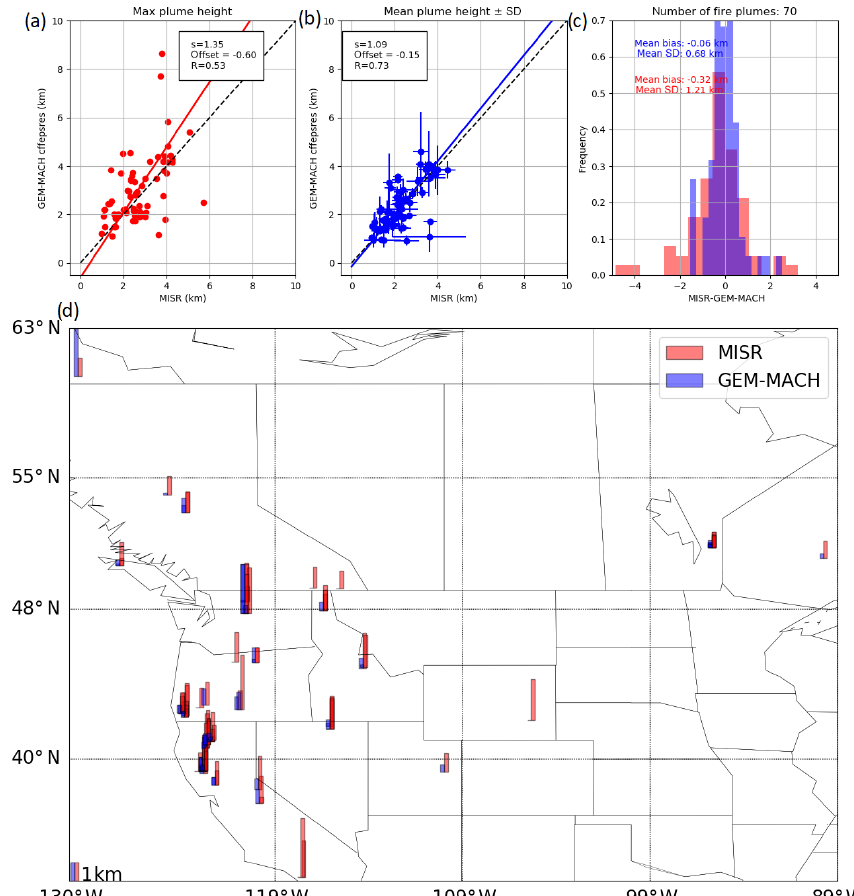
Figure 5. Modelled plume height versus MISR-derived plume height (a–c) . In total 70 fire plumes were compared (all between June and August 2018) in terms of (a) maximum plume height and (b) mean plume height within one wildfire plume, together with the statistics of the line of best fit (correlation coefficient, R , and slope, s ). Panel (c) shows the histogram for the differences in plume height (MISR − model) for the maximum (blue) and mean (red) plume height. Panel (d) shows the regional distribution of plume heights above ground level for MISR (red, left bar) and CFFEPS (blue, right